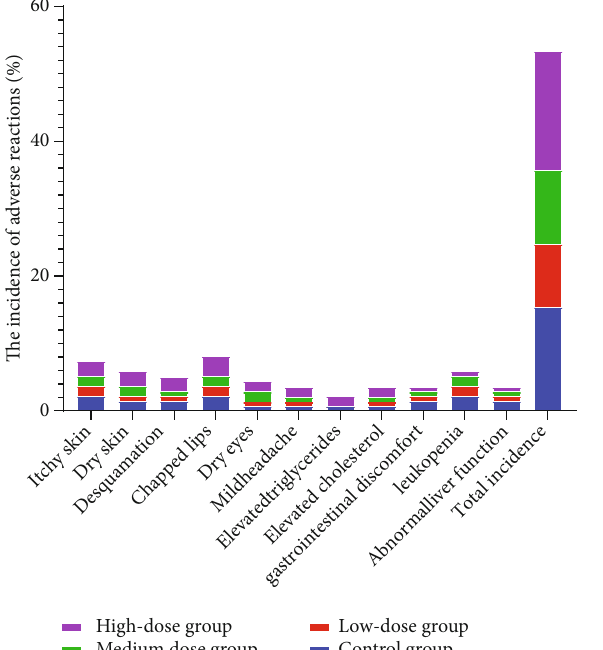
Figure 3: Comparison of the incidence of adverse reactions with four groups.